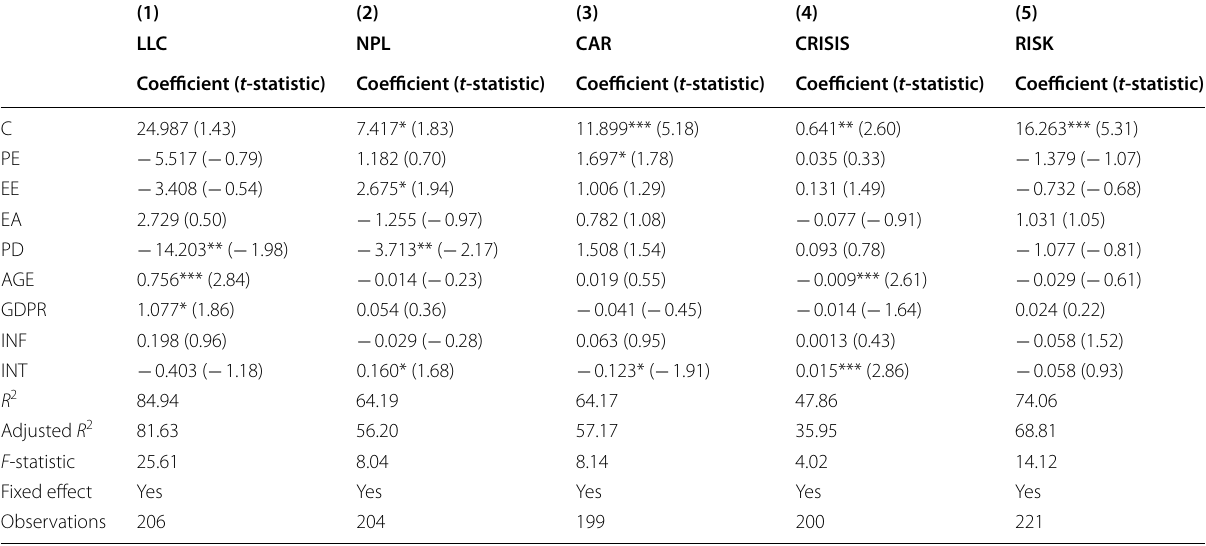
Table 2 Effect of competence on financial